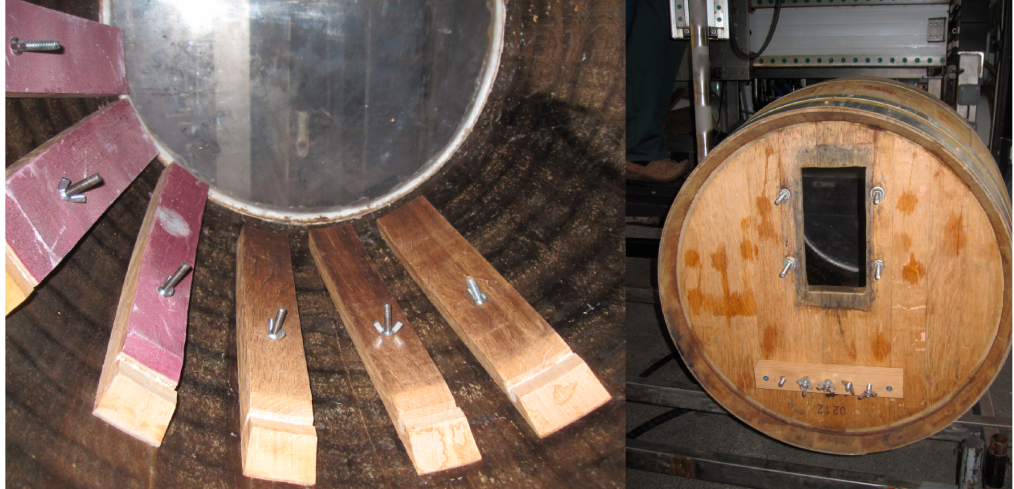
Figure 2. Experimental barrel for HPU treatment.